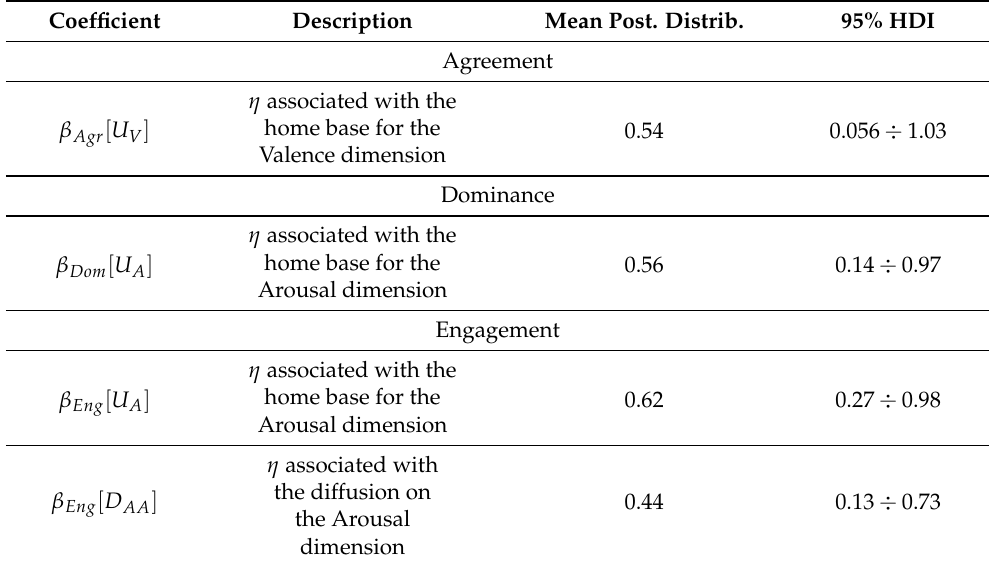
Table 2. Bayesian Linear Regression model coefficients not containing zero value in the HDI of the posterior.